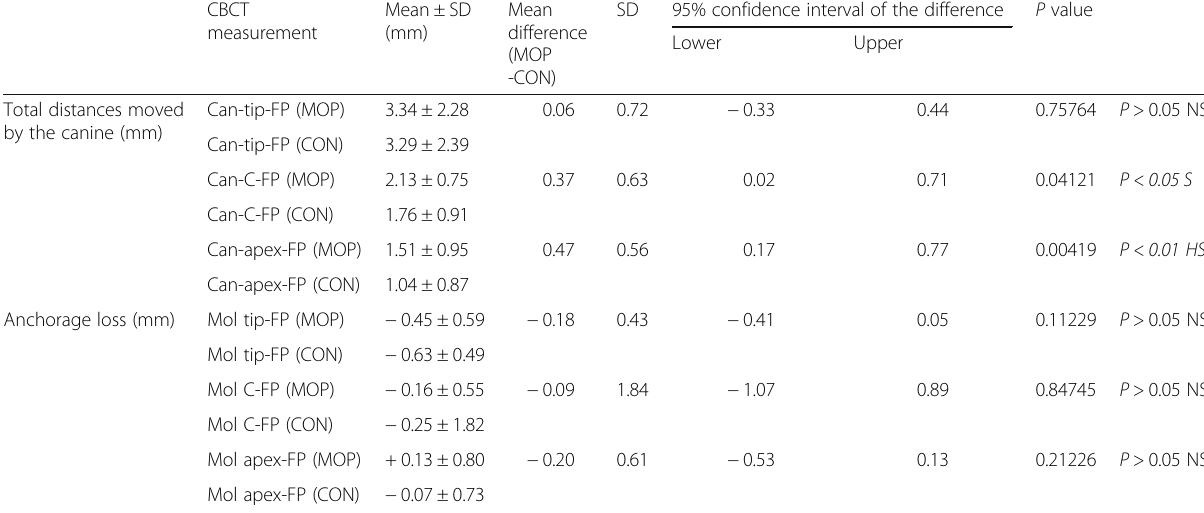
Table 1 The total distances moved by the canine and the anchorage loss in the MOP and control sides (paired sample t test)